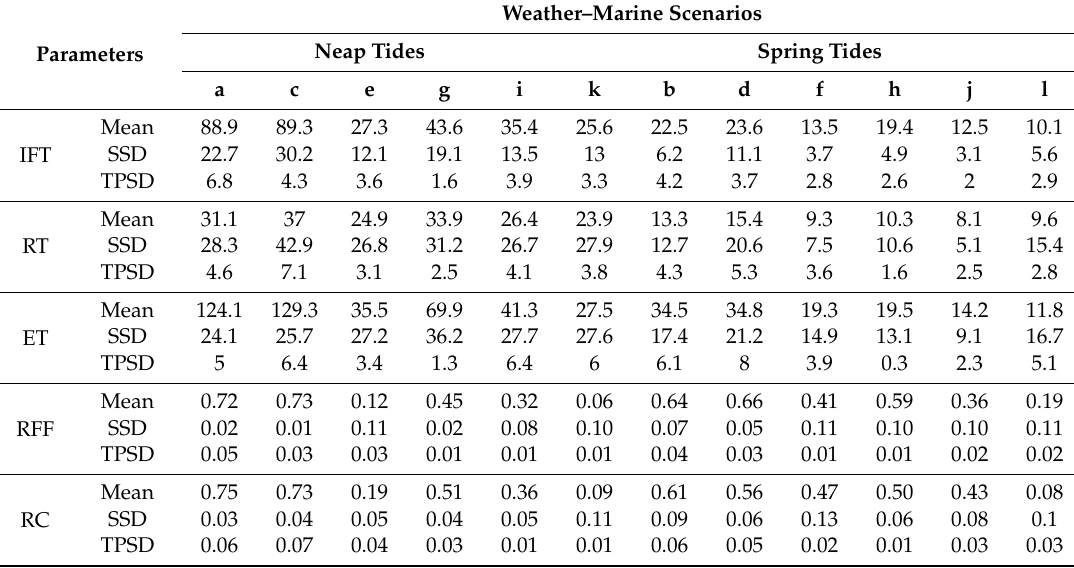
Table 4. Mean, Spatial Standard Deviation (SSD) and Tidal Phase Standard Deviation (TPSD) calculated for IFT, RT, ET, RFF and RC for the weather-marine scenarios (letters) defined in Table 1. Statistics results are in hours for IFT, RT and ET and without units for RFF and